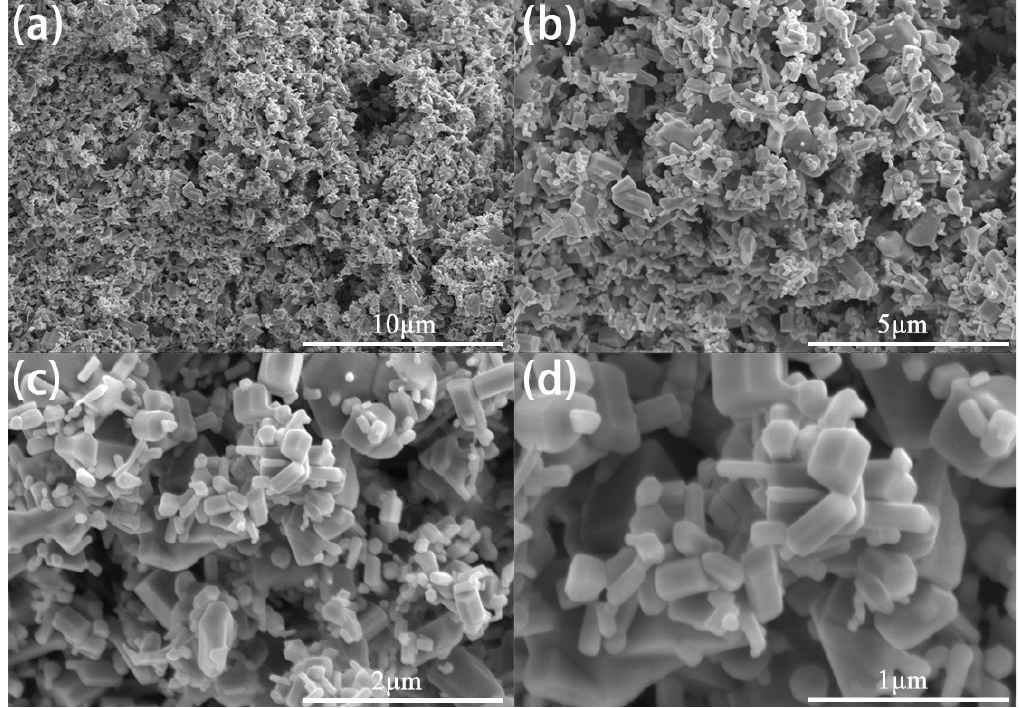
Figure 4. Scanning electron microscopy (SEM) images of the sample at different magnifications. ( a ) 5k, ( b ) 10k, ( c ) 25k, ( d ) 50k.